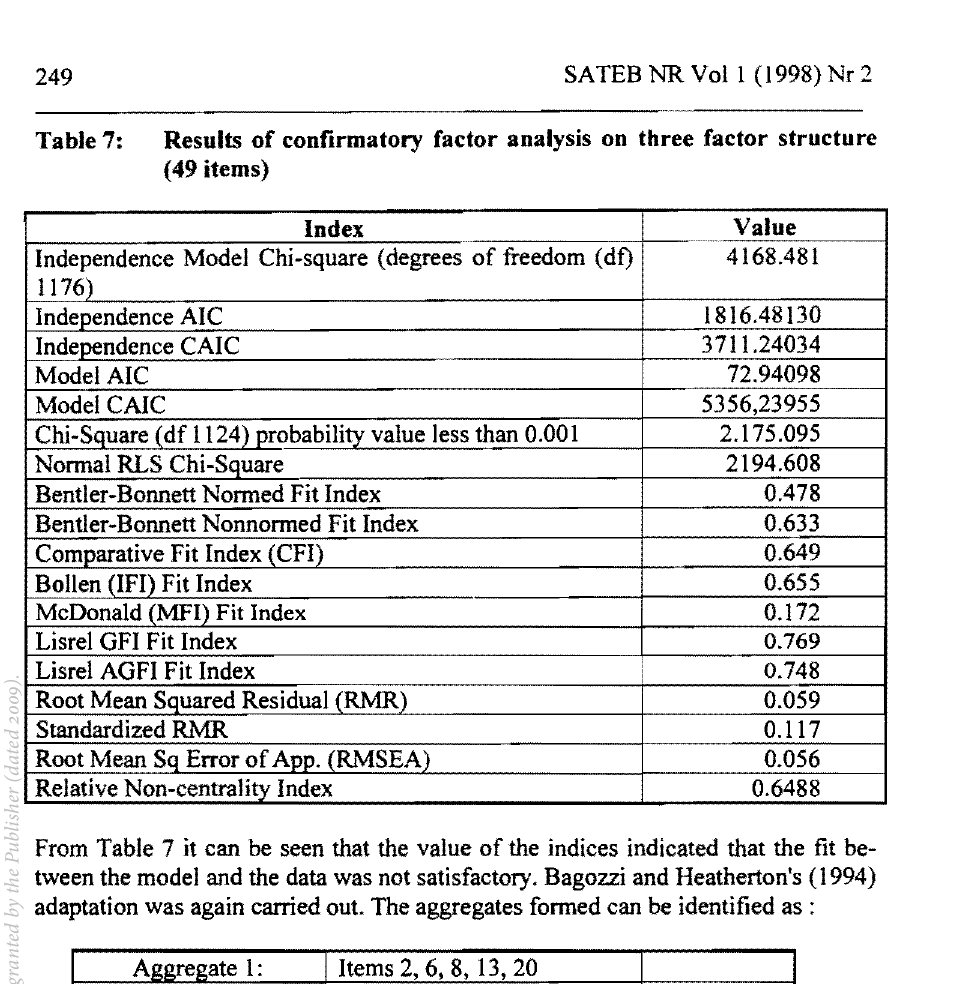
Table 7: Results of confirmatory factor analysis on three factor